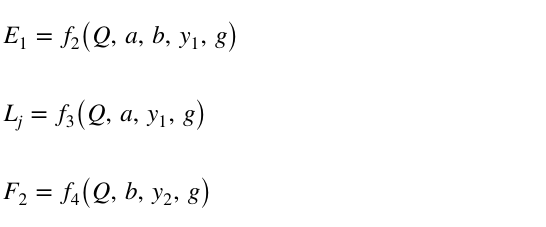
Table 1 Tailwater depth deficit parameter with respective upstream Froude Number ( F 1 )